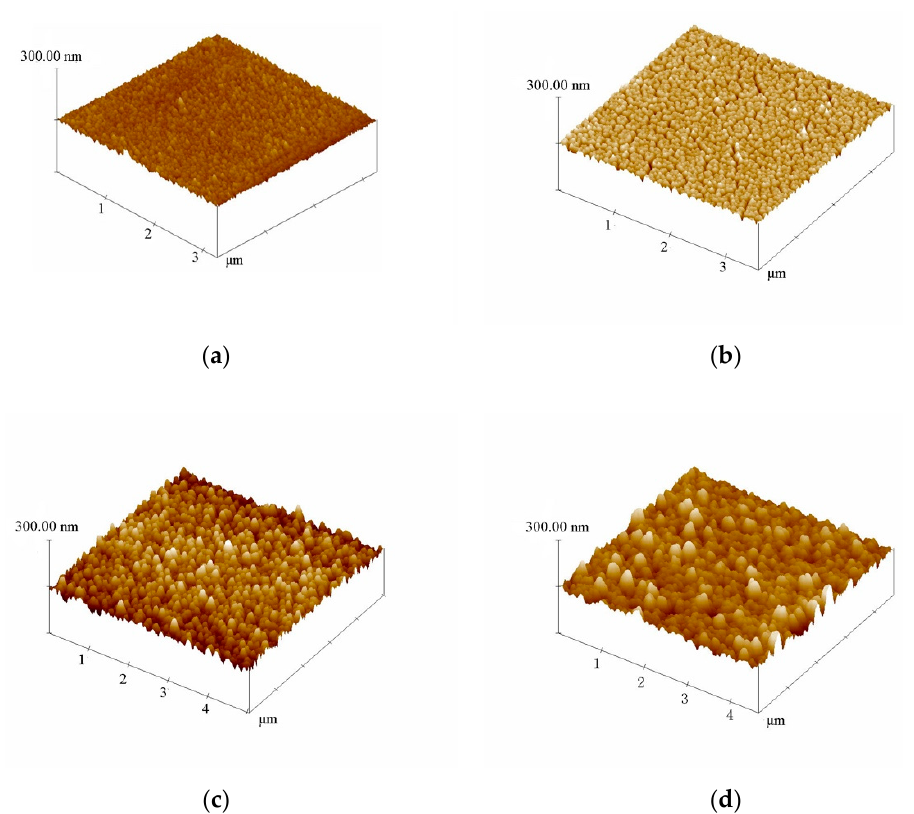
Figure 1. AFM images of different catalysts annealing at 650 °C for 60 min. ( a ) 100 nm Cu film; ( b ) 500 nm Cu film; ( c ) 100 nm Cu-Cr alloy film; ( d ) 500 nm Cu-Cr alloy film. AFM: Atomic Force Microscope.